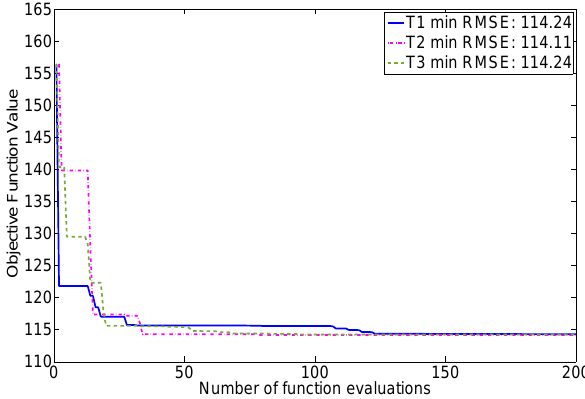
Figure 3. CLM4.5bgc CH 4 predictions when using the default pa- rameter values vs. the predictions when using the best solution found in each of the three optimization trials T1, T2, and T3, re- spectively, for the pseudo data case with d = 11 parameters. The legend shows the lowest RMSE value found in each trial.